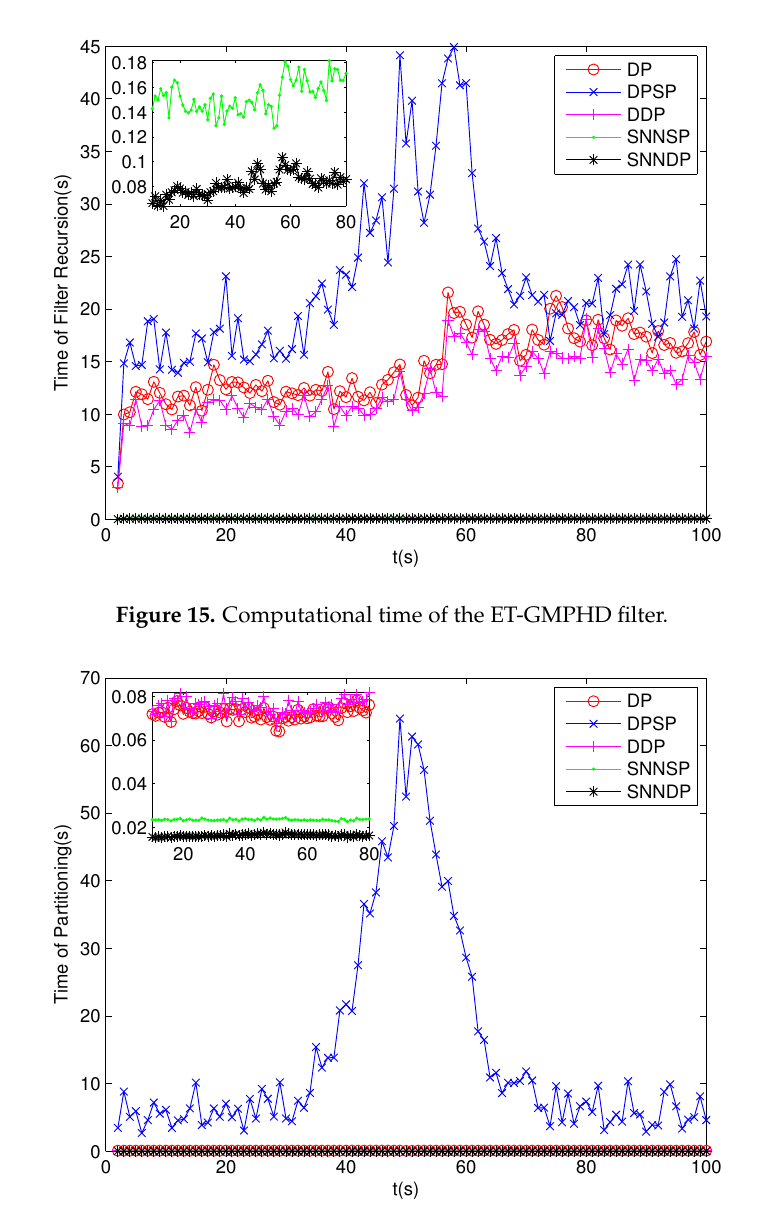
Figure 16. Computational time of